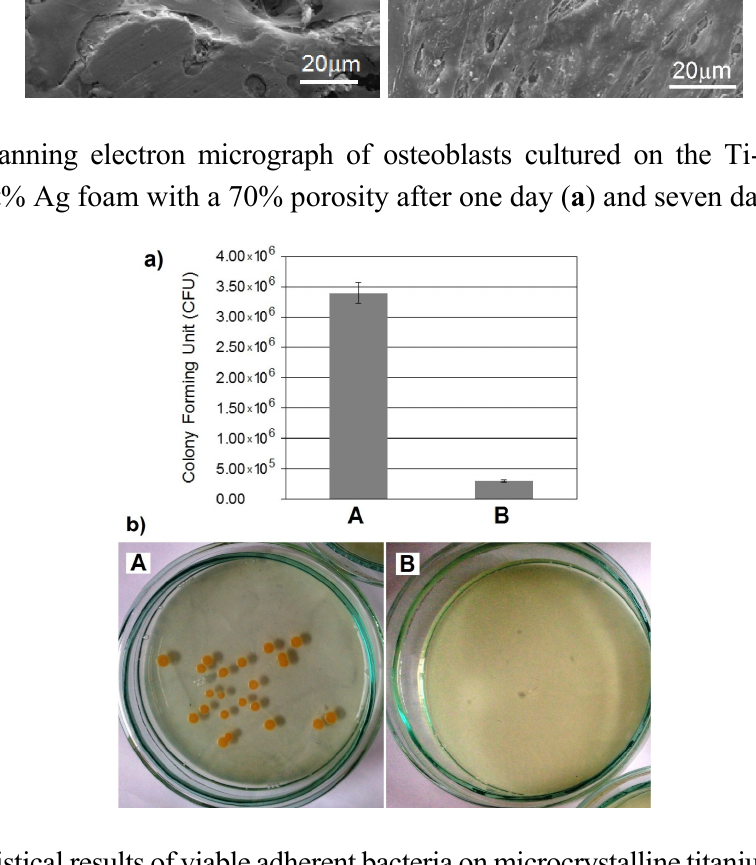
Figure 9. Statistical results of viable adherent bacteria on microcrystalline titanium (A) and bulk Ti-10 wt% 45S5 Bioglass-1 wt% Ag nanocomposite (B) ( a ) and representative macroscopic photos of viable adherent bacteria on difference experimental material surfaces ( b